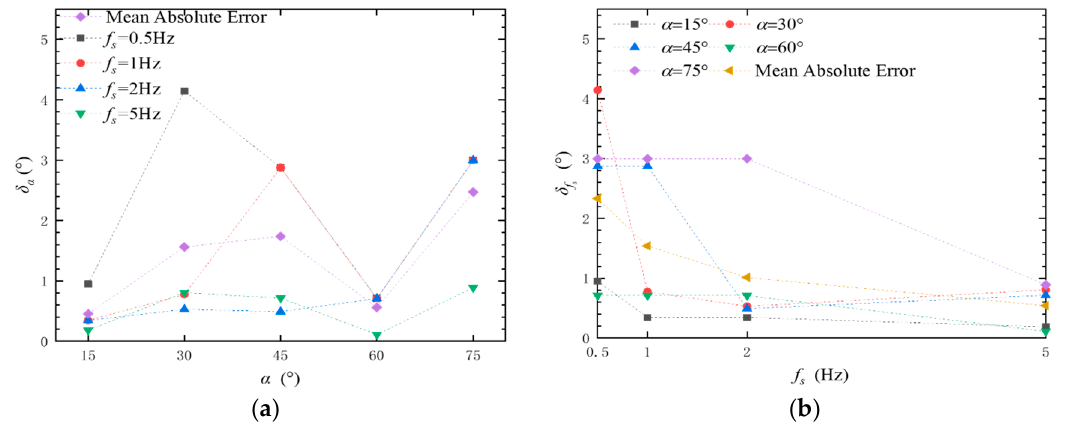
Figure 6. Estimation result of the attitude angle of the target with unknown size. ( a ) Variation of the absolute error of the attitude angle with the attitude angle. ( b ) Variation of the absolute error of the attitude angle with the spin rate.